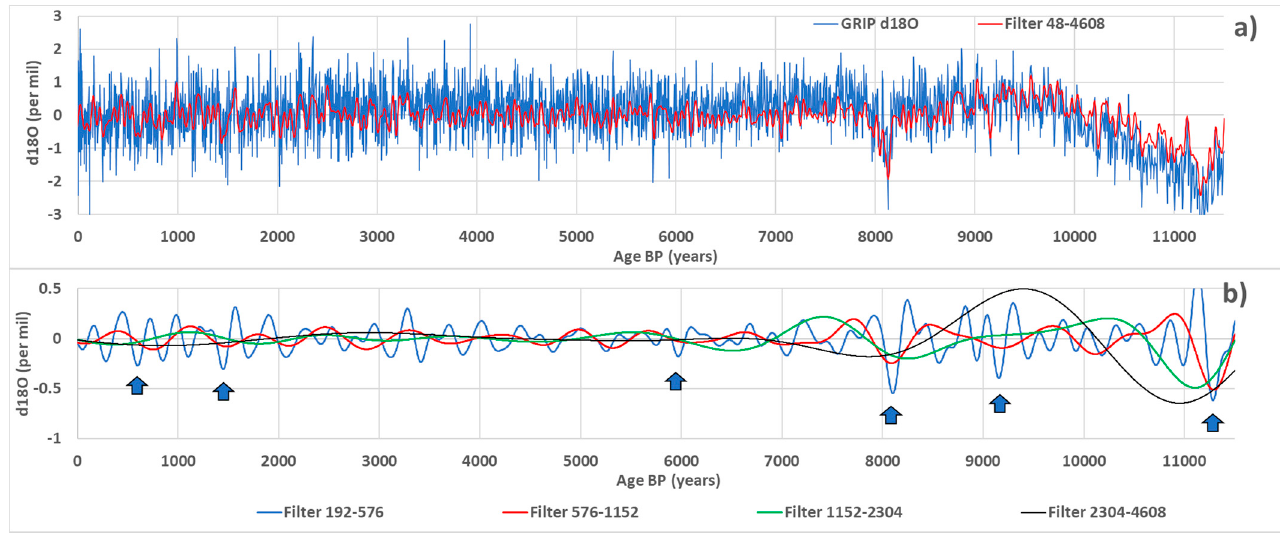
Figure 1. δ 18 O in GRIP ice core: ( a ) raw and filtered chronologies. A broad band is used to reconstruct the denoised chronology (sum of signals filtered in the bands 48–96, 96–192, 192–576, 576–1152, 1152–2304 and 2304–4608 years); ( b ) signals filtered in the 192–576, 576–1152, 1152–2304 and 2304–4608 year bands are characteristic of the subharmonic modes n 3 = 2 2 , n 4 = 3 × 2 2 , n 5 = 3 × 2 3 , n 6 = 3 × 2 4 (mean periods = 256, 768, 1536, and 3072 years). Blue arrows indicate Bond events at 610, 1450, 5970, 8100, 9150, and 11,260 years